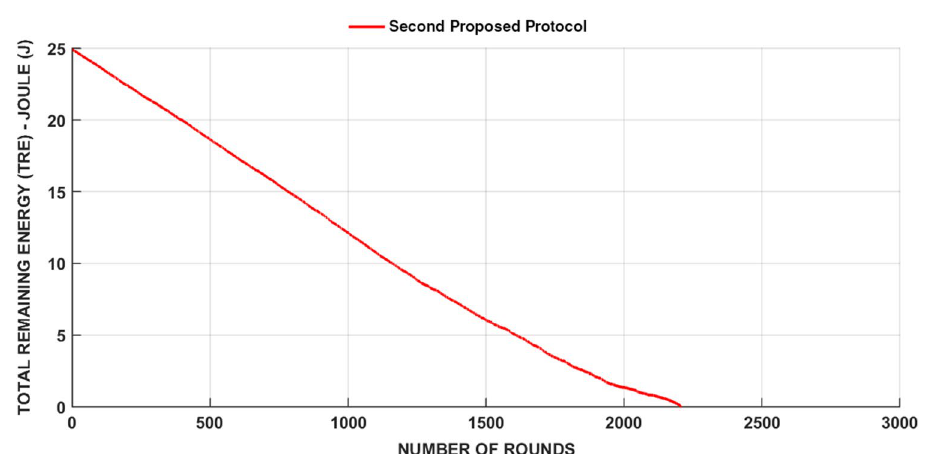
Fig. 20 Total remaining energy in relation to the number